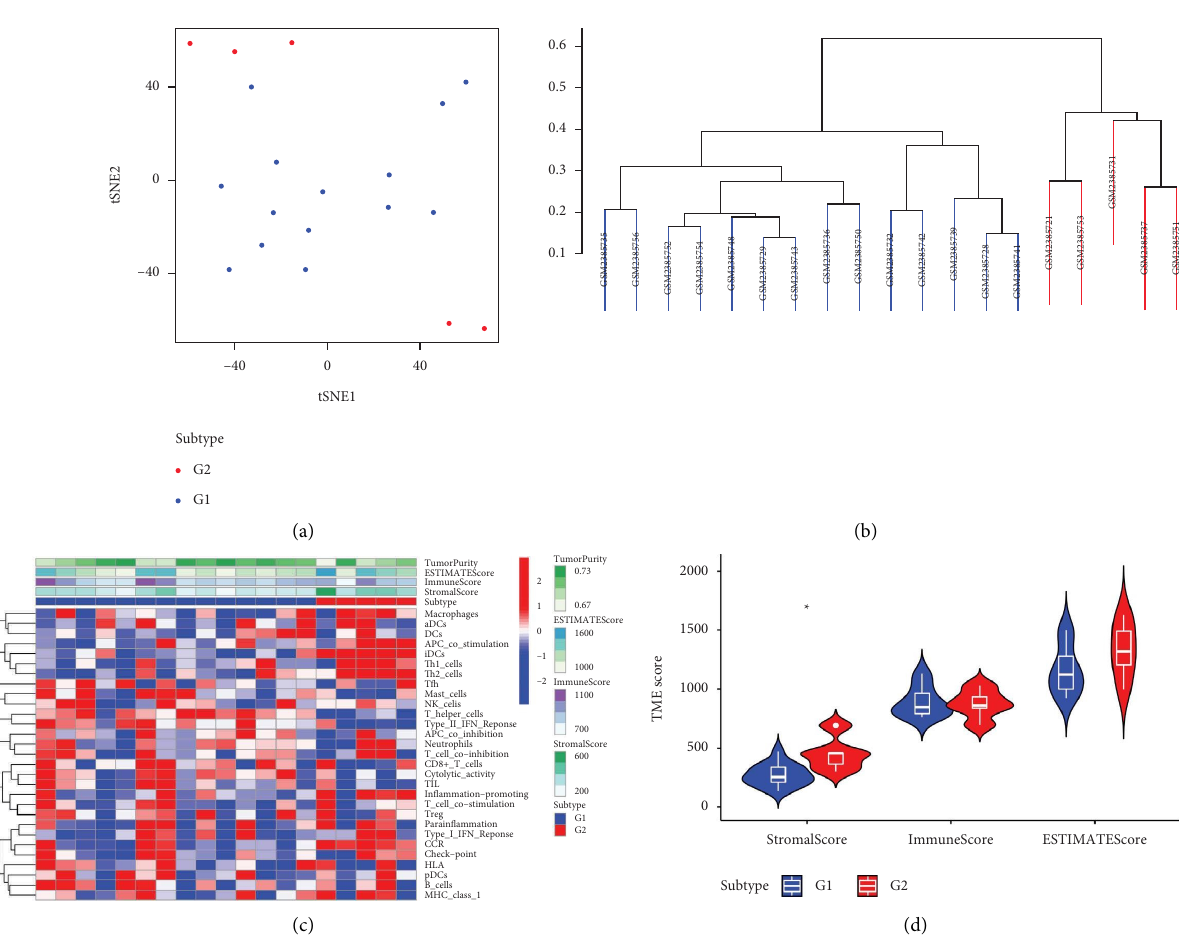
Figure 2: (a)-(b) Te subtype based on the expression of immune-related genes. (c) Te diferent expression of immune cells between diferent subtypes. (d) Te diferent immune scores between diferent